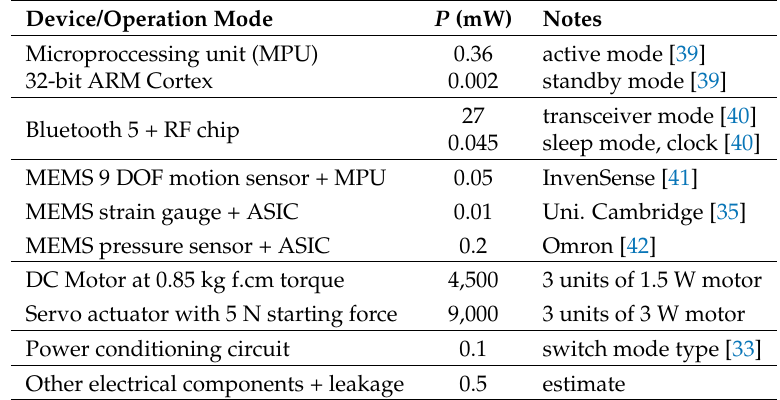
Table 2. Typical power requirements P of selected active components in bionics and smart